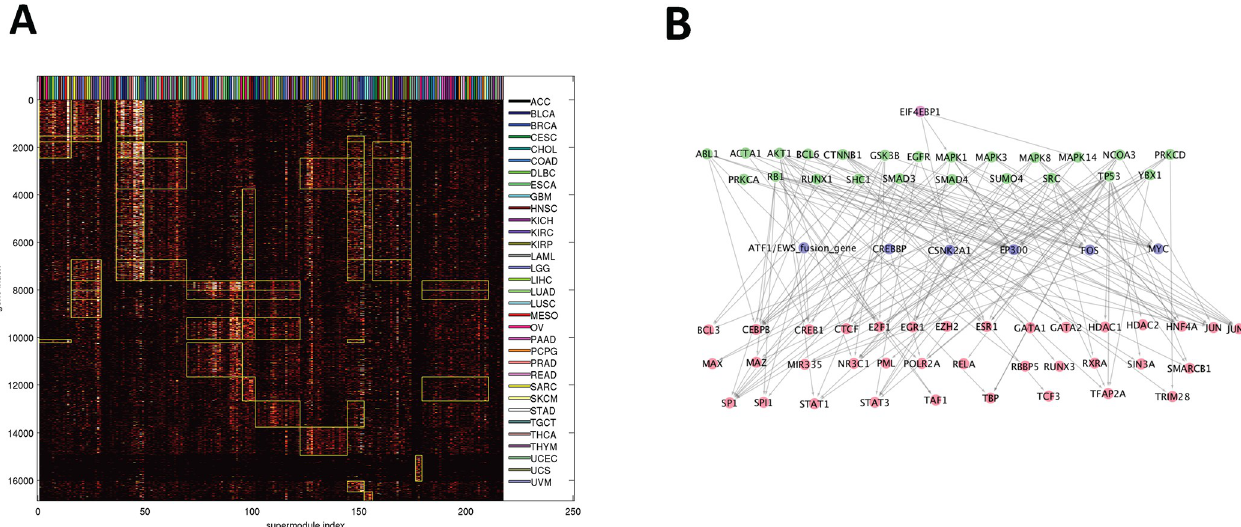
Fig 3. Summary of integrated hierarchical association structure. A : Memberships of 16860 target genes in 217 Super Modules. Super Modules (columns) are sorted by Super Module Groups, and genes (rows) are sorted by Gene Groups. The heat color of an entry reflects the number of modules encompassing a gene and belonging to a Super Module. A rectangular patch marked by yellow boundaries denotes that a Gene Group is over-represented in a Super Module Group. The cancer types of Super Modules are displayed on the top. B : Consensus Artery Network comprising indispensable interactions for explaining (effector, target) association pairs across multiple cancer types. The subnetwork spanned by highly connected hubs is displayed. Node colors denote hub levels: 1 (red), 2 (purple), 3 (green), 4 (magenta).